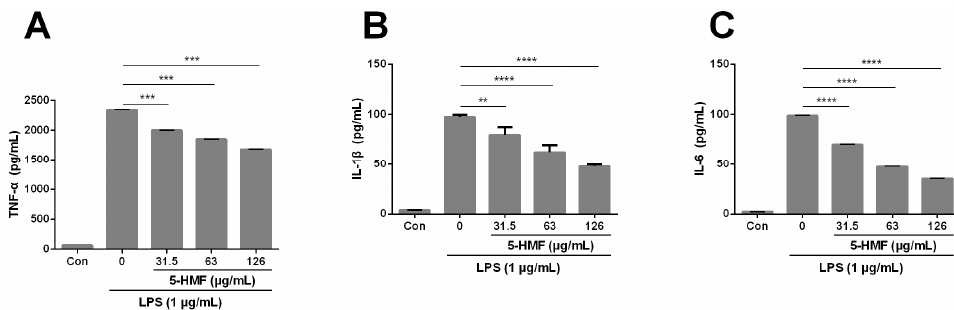
Figure 3. The effect of 5-HMF on the expression of TNF- α ( A ), IL-1 β ( B ) and IL-6 ( C ) in LPS-activated RAW 264.7 cells. Cells were pretreated with various concentrations of 5-HMF for 6 h prior to the stimulation of LPS (1 µ g/mL) for 18 h. The concentration of TNF- α , IL-6 and IL-1 β in the culture medium was analyzed using the respective ELISA kits, respectively. Data were expressed as means ± SDs (n = 3). **: P < 0.01, ***: P < 0.005, ****: P < 0.001, compared with the only LPS-stimulated control group.